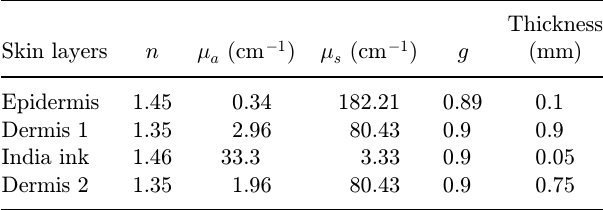
Table 1. Optical parameters of di®erent layers of skin model.